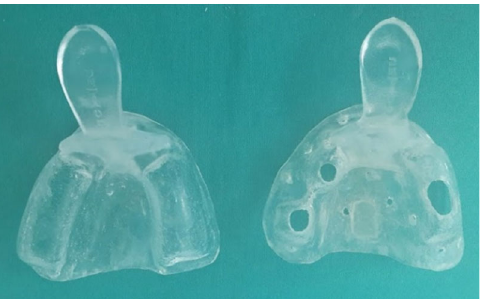
Figure 4. Showing closed ( left ) and open ( right ) tray for obtaining definitive impressions.